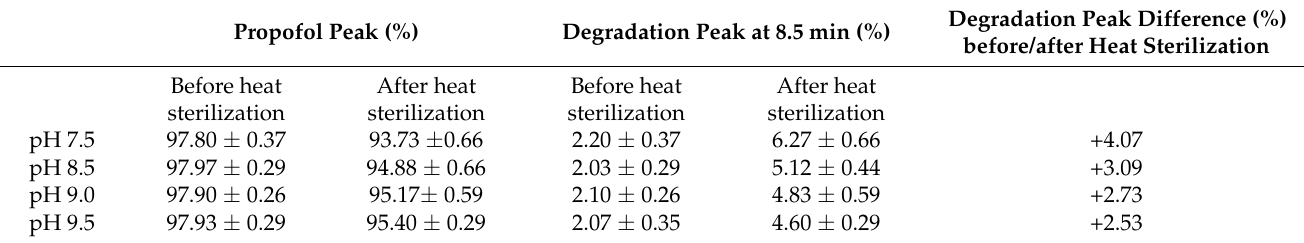
Table 8. Effect of heat sterilization and pH adjustment on chemical stability of propofol *. Propofol Peak (%) Degradation Peak at 8.5 min (%)